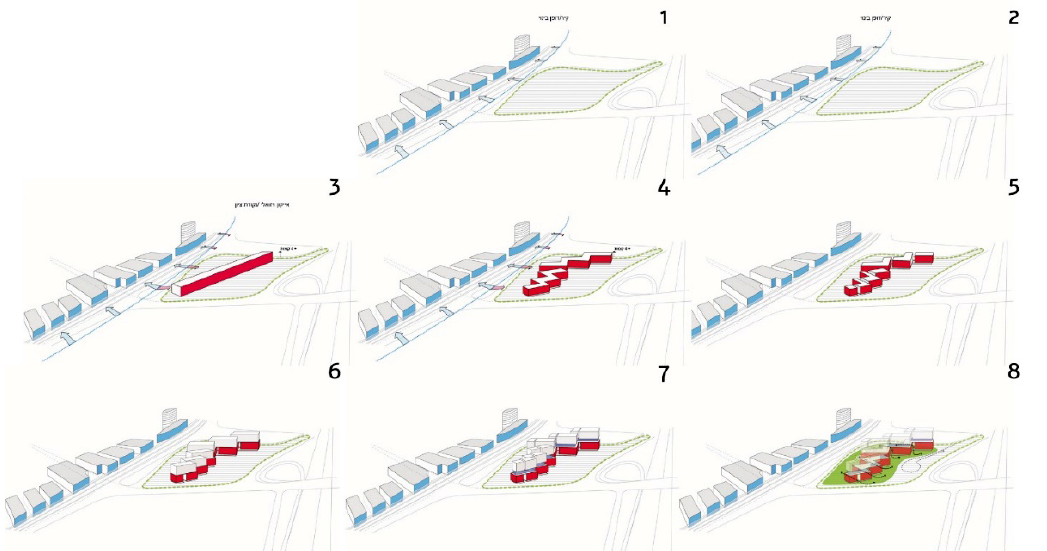
Figure 13. Braz’s linear-scheme: reassembling urban elements. Source: K. Braz private collection (2013). gular feature, is the result of the neoliberal city which is the “non-city.” Sanchinarro, planned as part of the ‘Programas de Actuación Urbanística,’ resulted from fill- ing the shortage in housing by sprawling the city to the suburb under the influence of the neoliberal policy deny-